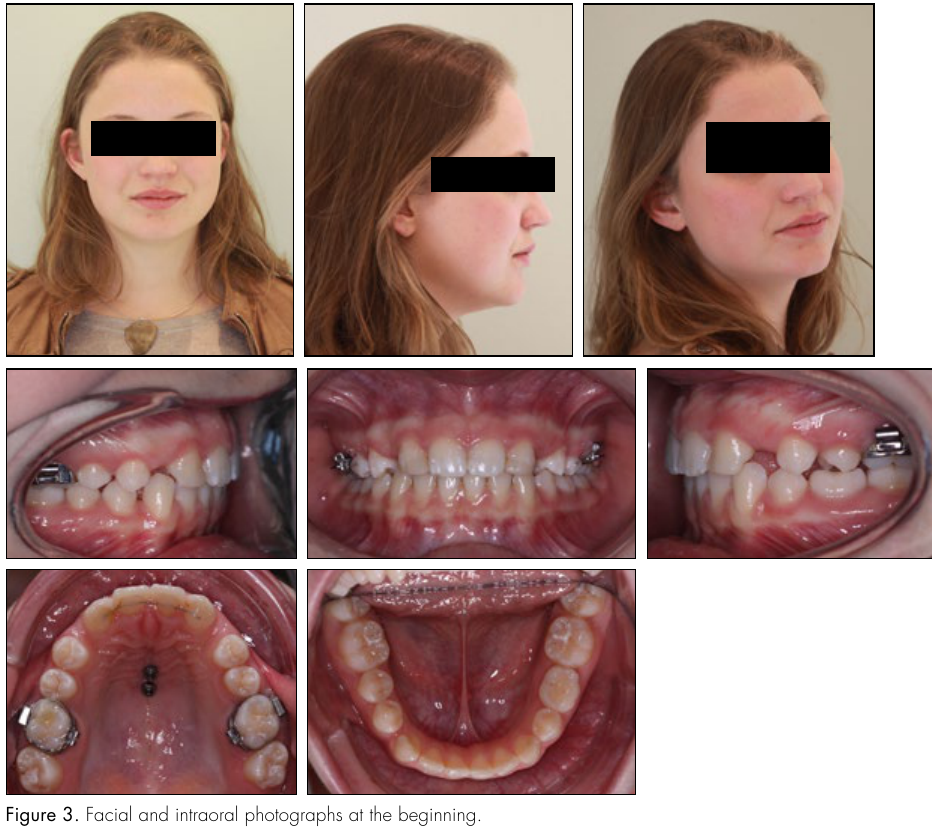
Figure 3. Facial and intraoral photographs at the beginning.